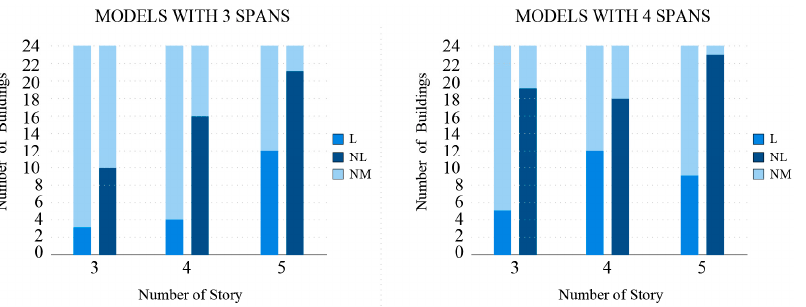
Figure 14. Distribution of buildings with sufficient performance according to the span num- ber/number of storeys.